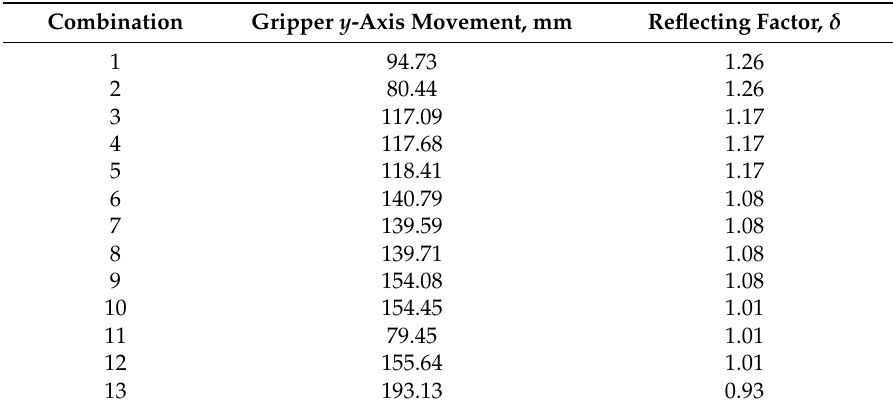
Table 5. Position analysis results based on the various dimensions of the picking device bars.